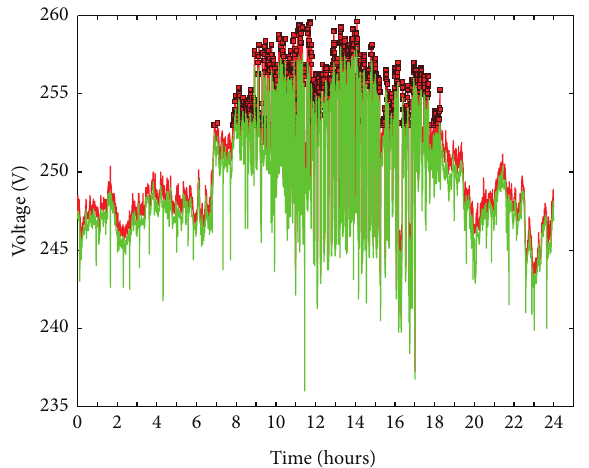
Figure 5: Voltages of the second facility during the recording period with the values sorted in descending